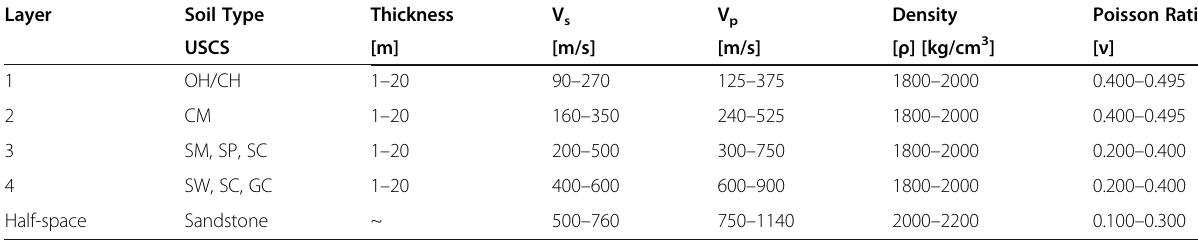
Table 1 Range values of initial parameters for H/V inversion